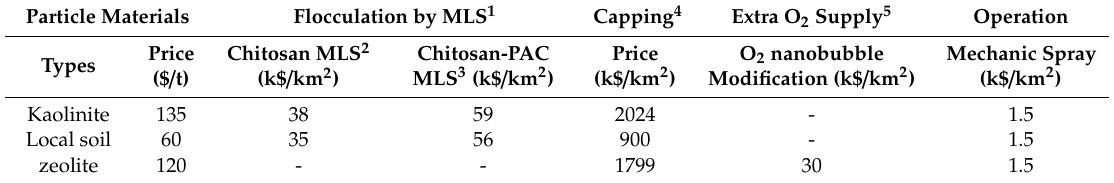
Table 3. Summary of the cost per km 2 of field implementation of Modify Local Soil (MLS) technology. Particle